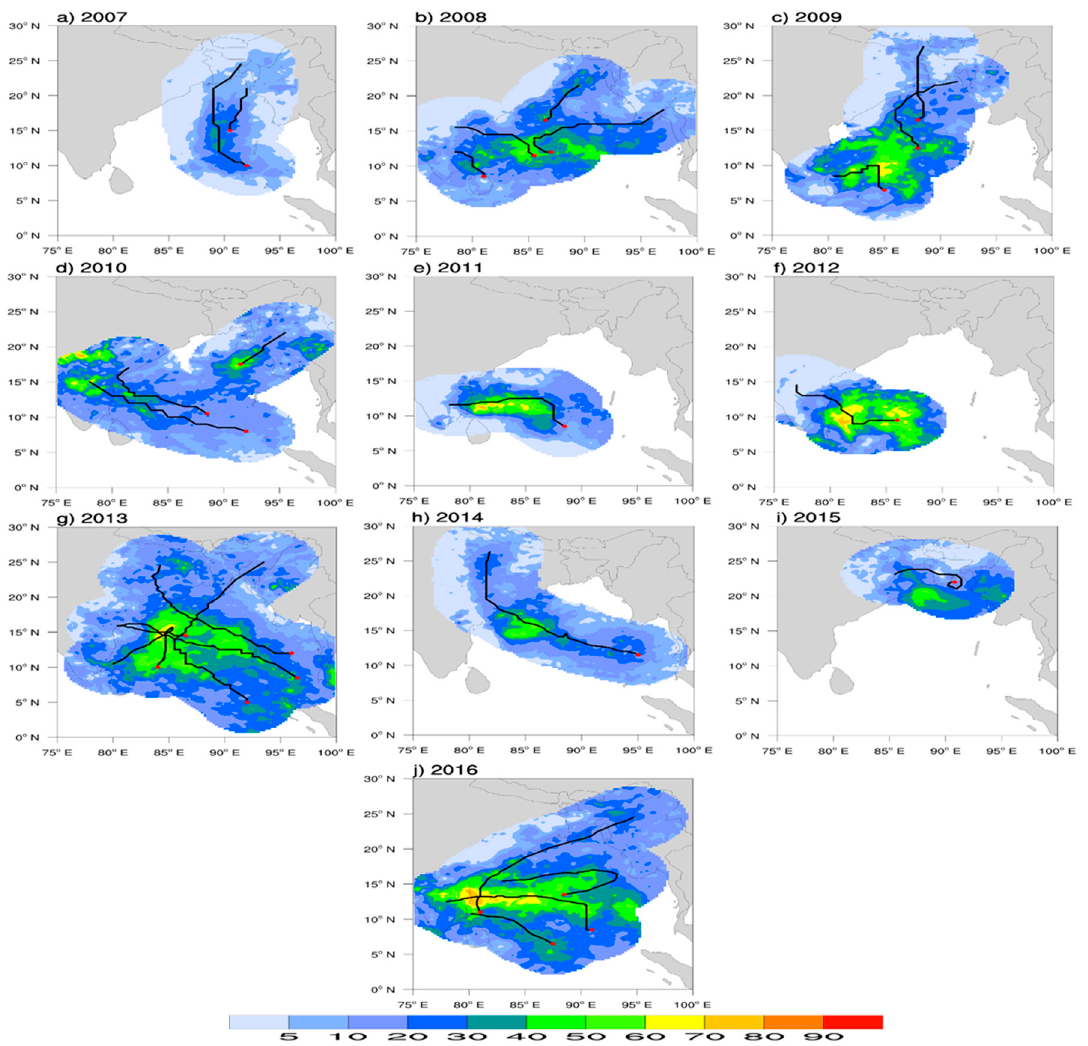
Figure 7. Same as Figure 6 but for 2007–2016. ( a ) 2007, ( b ) 2008, ( c ) 2009, ( d ) 2010, ( e ) 2011, ( f ) 2012, ( g ) 2013, ( h ) 2014, ( i ) 2015, ( j ) 2016.